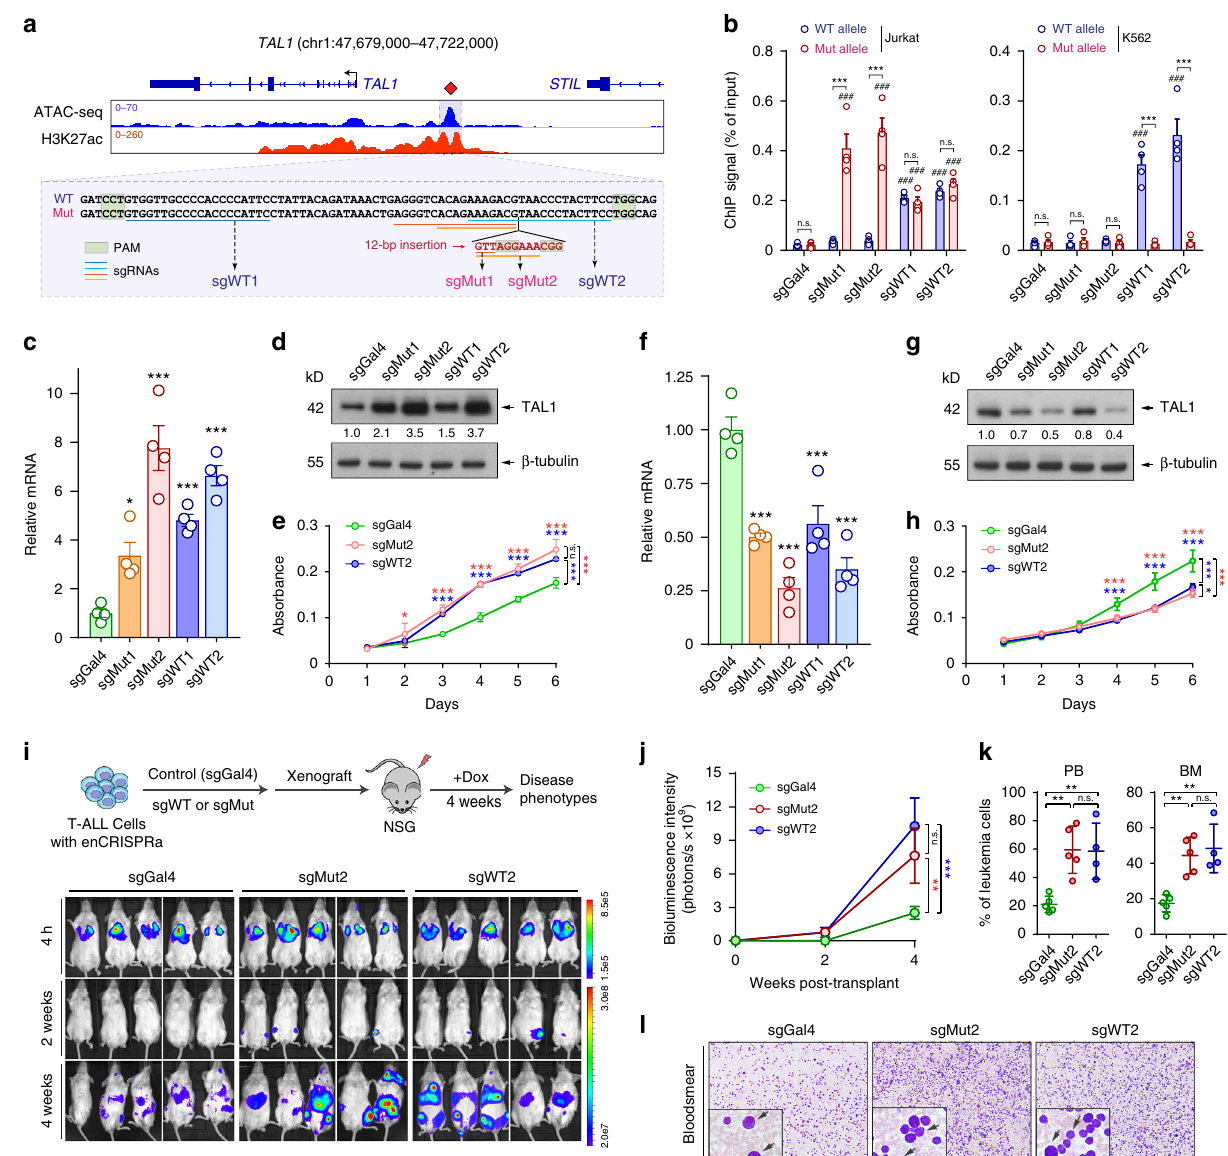
Fig. 4 Perturbations of TAL1 oncogenic super-enhancer in xenografts. a Density maps are shown for ATAC-seq and H3K27ac ChIP-seq at TAL1 (chr1:47,679,000 – 47,722,000; hg19) in Jurkat cells. The TAL1 oncogenic SE is shown as blue shaded lines. The positions of sgRNAs and PAM sequences are shown as colored lines and boxes, respectively. b Chromatin occupancy of dCas9-p300 by target-speci fi c (sgMut1, sgMut2, sgWT1 and sgWT2) or nontargeting sgGal4 in Jurkat or K562 cells. ChIP signals (% of input) are shown as mean ± SEM ( n = 4 experiments). c Expression of TAL1 mRNA in Jurkat cells upon enCRISPRa-mediated enhancer activation. Results are mean ± SEM ( n = 4 experiments). d Expression of TAL1 protein upon enCRISPRa- mediated enhancer activation. The quanti fi ed TAL1 expression is shown. e Activation of TAL1 SE promoted T-ALL growth in vitro. Relative absorbance by cell viability assays ( y axis) at different days of culture ( x axis) is shown ( n = 3 experiments). f Expression of TAL1 upon enCRISPRi-mediated enhancer repression in Jurkat cells. Results are mean ± SEM ( n = 4 experiments). g Expression of TAL1 protein upon enCRISPRi-mediated enhancer repression. h Repression of TAL1 SE impaired T-ALL growth in vitro ( n = 3 experiments). i Activation of TAL1 SE promoted T-ALL growth in NSG mice xenografted with Jurkat cells transduced with sgGal4, sgMut2 or sgWT2, respectively. Bioluminescence intensity is shown at 4 h, 2 and 4 weeks post transplantation. j Quanti fi cation of bioluminescence intensity is shown. Results are mean ± SEM ( n = 5 recipients per group). k Frequencies of leukemia cells in BM and PB of xenografted NSG mice 4 weeks post transplantation. Results are mean ± SEM ( n = 5, 5, and 4 recipients for sgGal4, sgMut2 and sgWT2, respectively). l Representative bloodsmear images of NSG mice 4 weeks post transplantation. The inset images indicate the zoom-in view. Representative leukemia cells are indicated by arrowheads. Scale bars, 200 and 20 µ m for full and insert images, respectively. Results are mean ± SEM and analyzed by a one-way or two-way ANOVA. * P < 0.05, ** P < 0.01, *** P < 0.001, ### P < 0.001, n.s. not signi fi cant. Source data are provided as a Source Data fi In vivo functional interrogation of lineage-speci fi c enhancers . comparable in WT and KI mice with or without Dox treatment (Supplementary Fig. 6d – f), indicating that the inducible dCas9- Hematopoiesis serves as a paradigm for understanding stem cell KRAB expression does not affect normal blood development. differentiation controlled by lineage-specifying TFs 48 . The self- renewing hematopoietic stem cells (HSCs) give rise to all mature